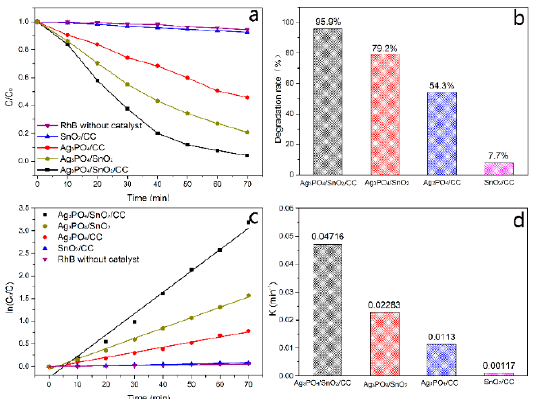
Figure 7. Time-course variation of C / C 0 of RhB over various catalysts ( a ). The degradation rate of various catalysts ( b ). The plots of ln(C 0 / C) versus time of various catalysts ( c ). The calculated k for the degradation of RhB over various catalysts ( d ).